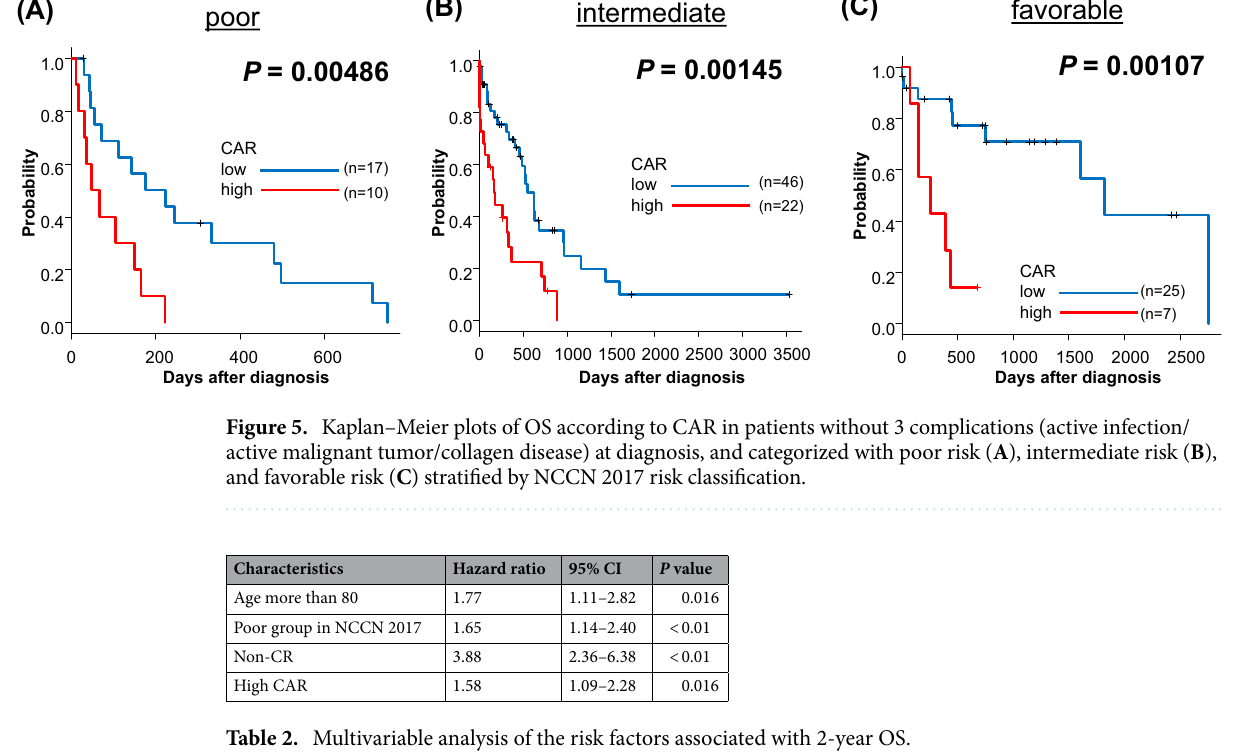
Table 2. Multivariable analysis of the risk factors associated with 2-year